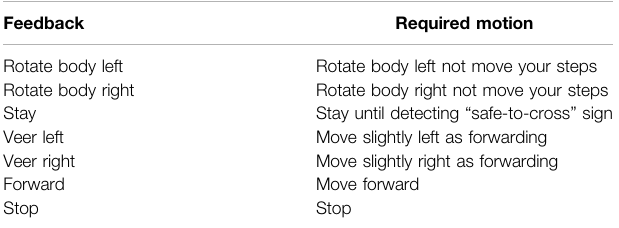
TABLE 2 | Verbal cues provided to guide alignment and